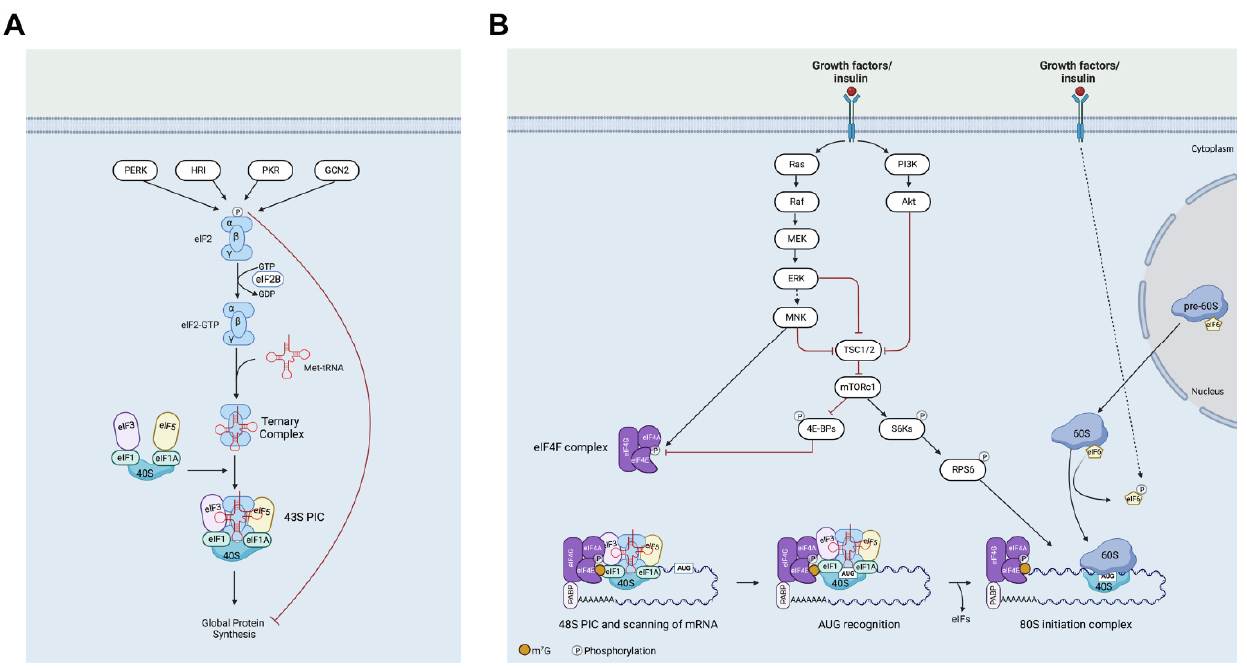
Figure 1. Diagram of the main phases of translational initiation: ( A ) 43S formation. eIF2 ternary complex formation is essential for the initiation of cellular mRNAs. The ternary complex, eIF2, GTP, and Met-tRNA binds the 40S subunit and delivers Met-tRNA to the start codon. Phosphorylation of the α -subunit of eIF2 prevents the formation of the eIF2/GTP/Met-tRNA complex and stops global protein synthesis. Phosphorylation of eIF2 α can be achieved by four distinct kinases that can inhibit ternary complex availability by reducing GTP exchange by eIF2B. ( B ) From 48S formation to 80S. The delivery of capped mRNA to the ribosome and scanning to the first start codon is highly dependent on the eIF4F complex, schematically composed of eIF4A helicase, the cap-binding protein eIF4E, and eIF4G. Here, the signaling pathways control initiation at least on two very distinct levels. First, the PI3K-mTORc1 cascade phosphorylates and inactivates a competitor of eIF4E binding to the cap, 4E-BP (multiple isoforms of 4E-BP exist). Second, the RAS-RAF cascade activates Mnk kinase (two isoforms), which phosphorylates eIF4E. Downstream of 48S formation, 60S availability is regulated by eIF6 phosphorylation. The event is complicated by other signaling regulations, such as rPS6 phosphorylation by S6 kinases downstream of mTOR (depicted) or rPS6 kinase downstream of ERK (not depicted). For details, please refer to [29].